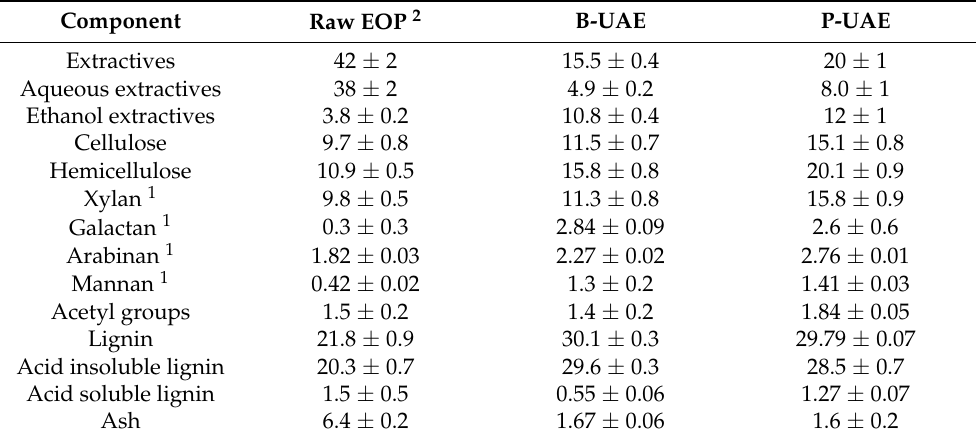
Table 9. Chemical composition of the exhausted olive pomace (EOP) before and after bath (B)- and probe (P)-ultrasound assisted extraction (UAE). Data (%, dry weight basis) represent the average value and standard deviation (n =